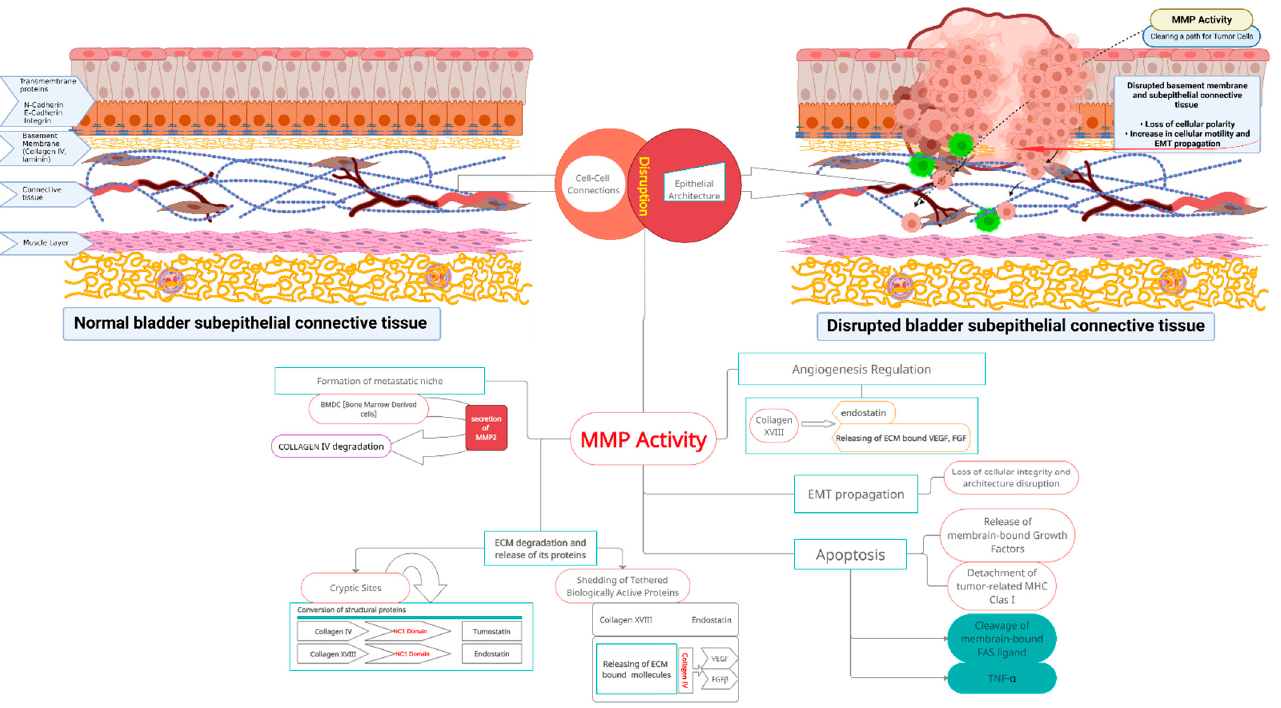
Figure 1. MMP activity and related molecular events during bladder cancer propagation. Upper left part of the diagram: Normal bladder wall structure. Correct epithelial architecture and polarity provided by the indicated adhesion molecules, and with a normal basement membrane. Layered self-assembled collagen IV and laminin networks blend intact basement membrane (yellow). Regular structure of underlying connective and muscle tissues. Intact layered structure of bladder wall is cru- cial in proper bladder physiology. Upper right part of the diagram: Gradual bladder wall disruption related to aberrant MMP activity. Cleavage of intercellular junctions, along with basement membrane remodeling and further loss of polarity of the urothelium, increased cell motility with propagation of epithelial-to-mesenchymal transition. Cancer cells traverse degraded supporting barrier (formerly continuous basement membrane). Center of the diagram: Degradation of extracellular matrix me- diated by matrix metalloproteinases 2 and 9 released by cancer cells, and accompanying cells from tumor-associated microenvironment cleave components of the basement membrane and underlying connective tissue, and generate new derivative molecules. As a result, extracellular matrix structural proteins and matrix-bound latent signaling molecules are converted into biologically active signaling molecules that are converted into active mediators. Activity of those products (products listed in the following segments of central part of the scheme) results in further cancer cells chemoattraction, proliferation, infiltration of deep tissues, aberrant neo-angiogenesis, inhibition of apoptosis in cancer cells, and formation of cancer niches. These molecular events contribute to bladder cancer progression from non-muscle to muscle-invasive tumors. MMP actions that take place after MMP activation are explained in the body